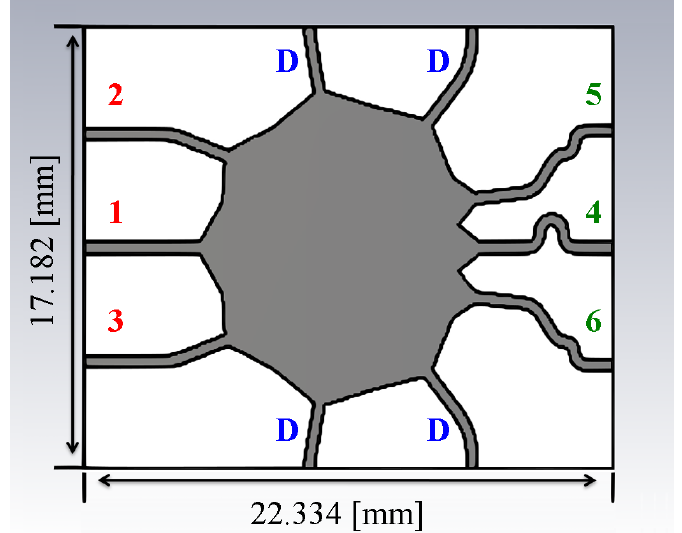
Figure 10. Proposed Rotman lens architecture with three inputs (red), three outputs (green), and four dummy (D) ports (blue) in the side walls. The scale is 10:3.06